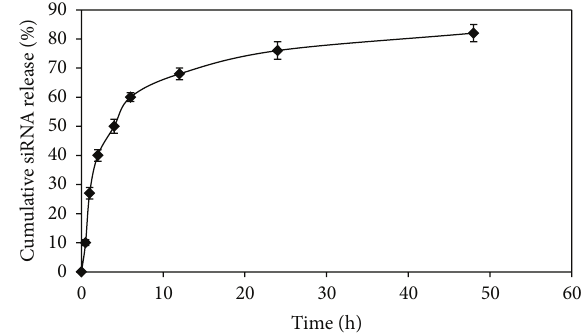
Figure6:ThereleaseprofileofsiRNAloadedCSNPsatDS :CSratio of 1:1 at pH 7.4, 𝑛 = 3